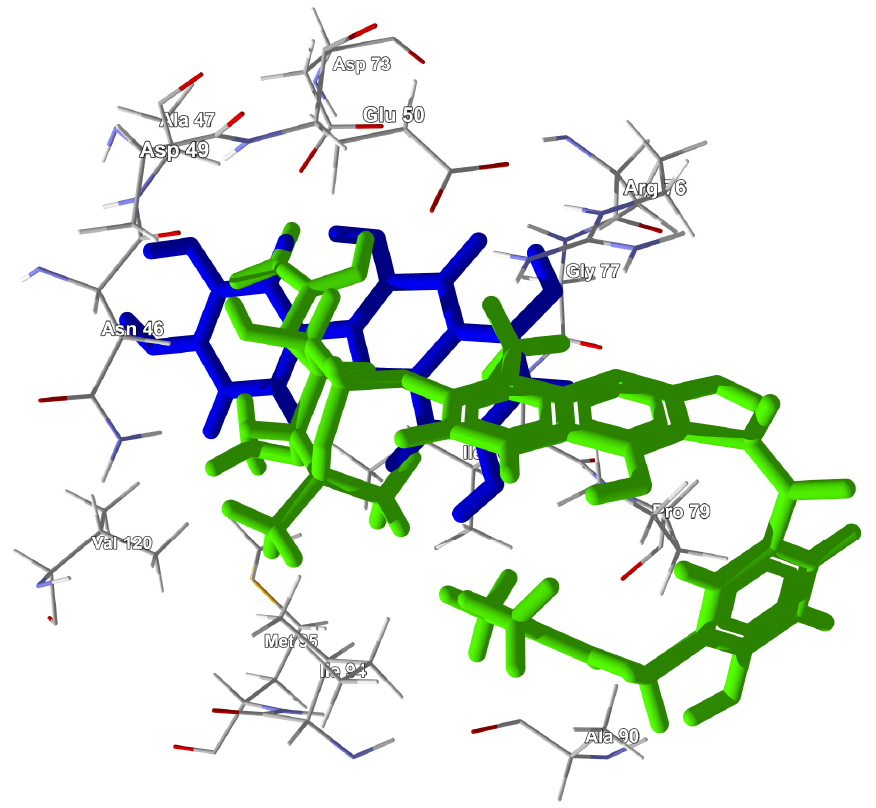
Figure 26. Lowest-energy docked pose of quercetin (272) ( blue ) in the novobiocin ( green ) binding site of Escherichia coli DNA gyrase B (PDB 1AJ6).